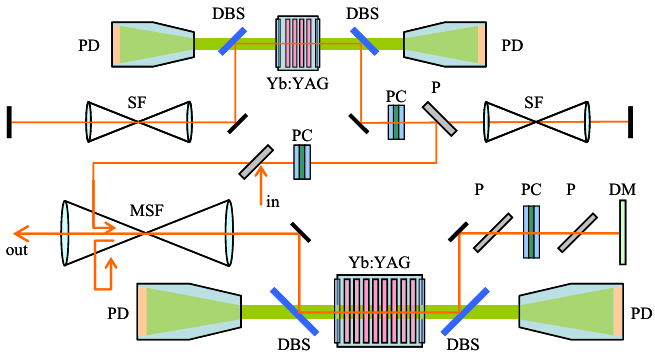
Figure 1. Optical layout of the laser system consisting of 10 J pre-amplifier and 100J amplifier. Shown are amplifiers heads with laser slabs (Yb:YAG), dichroic beam splitters (DBS), pumping modules (PD), spatial filters (SF), multipass spatial filter (MFS), polarizes (P), Pockels cell (PC), and deformable mirror (DM).